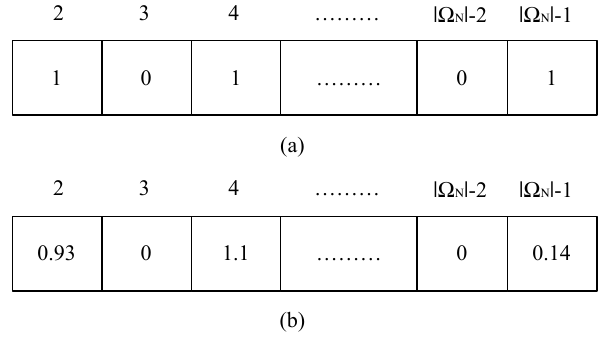
Figure 6. Configuration for locating and sizing Distributed Generators (DGs): ( a ) location of distributed generation; ( b ) sizing of distributed